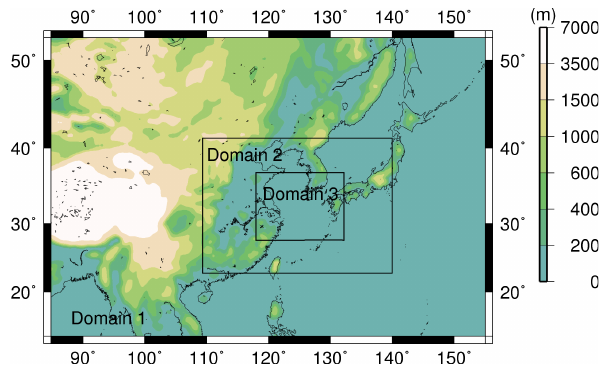
Fig. 10. Computational domain of this study. Colours indicate the topography of Domain